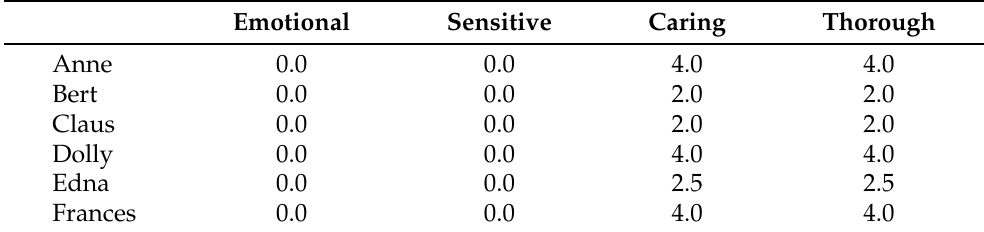
Table 1. Matrix of situation 1: “applying for an examen” for behavioral level data.